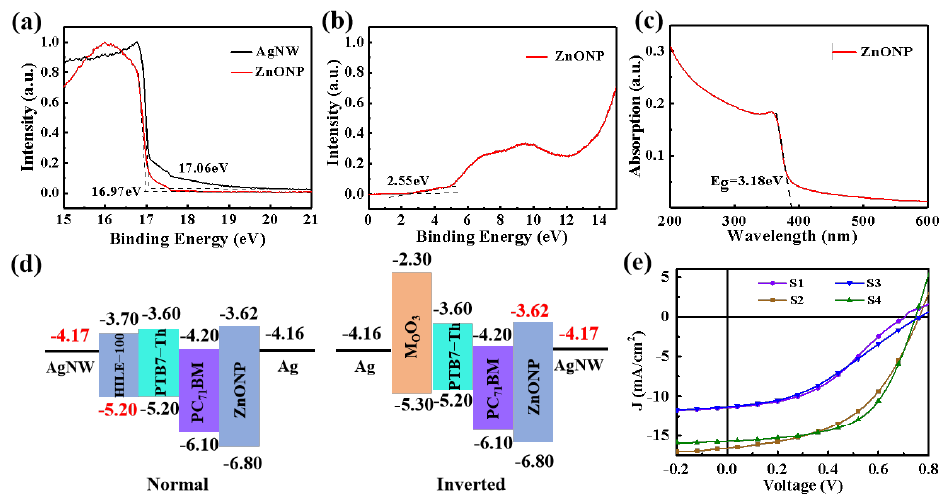
Figure 3. ( a ) UPS secondary electrons cut-off edge spectra of AgNW and ZnONP. ( b ) UPS valence-band maximum spectrum of ZnONP. ( c ) The absorption spectrum of ZnONP. ( d ) Energy band alignment diagrams of devices with PI/AgNW as anode or cathode. ( e ) J – V curves of flexible S1 and S2 devices in comparison with the control rigid S3 and S4 devices.